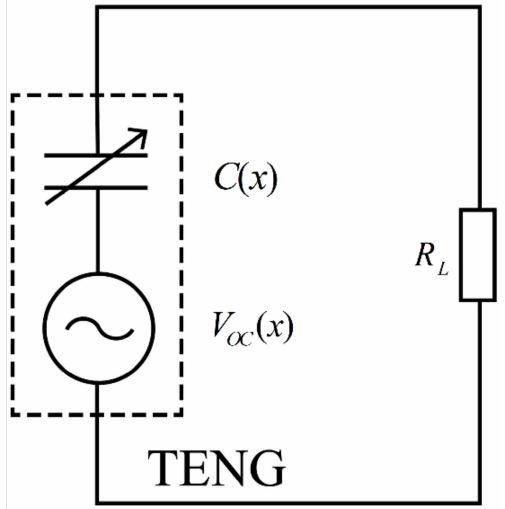
Figure 1. Schematic diagram of the